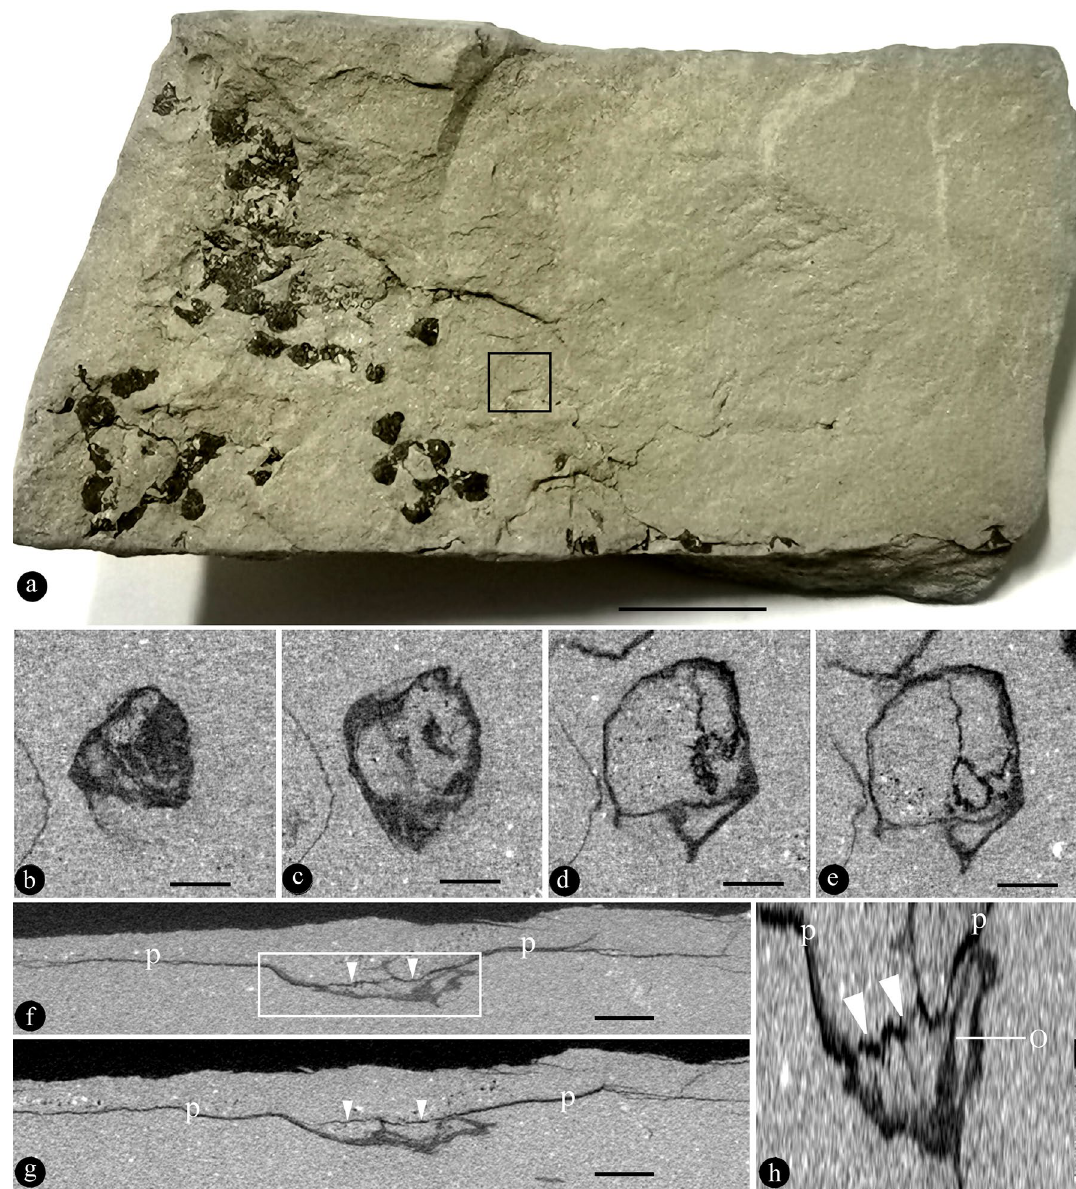
Figure 2. Nanjinganthus dendrostyla and its ovules within the ovary. PB180516. All scale bars = 1 mm, except annotated. ( a ) Several coalified compressions embedded in siltstone. Scale bar = 1 cm. ( b – e ) Virtual cross sections, in an ascending order, of the ovary of a flower fully embedded (invisible, in the rectangle in a ) in the specimen shown in ( a ). ( f , g ) Two virtual vertical sections of the flower shown in ( b–e ), showing an ovary with an ovary roof (triangles) and petals (p). ( h ) A detailed view of the rectangular region in ( f ), showing a funipendulous ovule (o) attached to the inner wall of the ovary that has a roof (triangles) and petals (p). To make it easy to observe, the figure is vertically stretched by